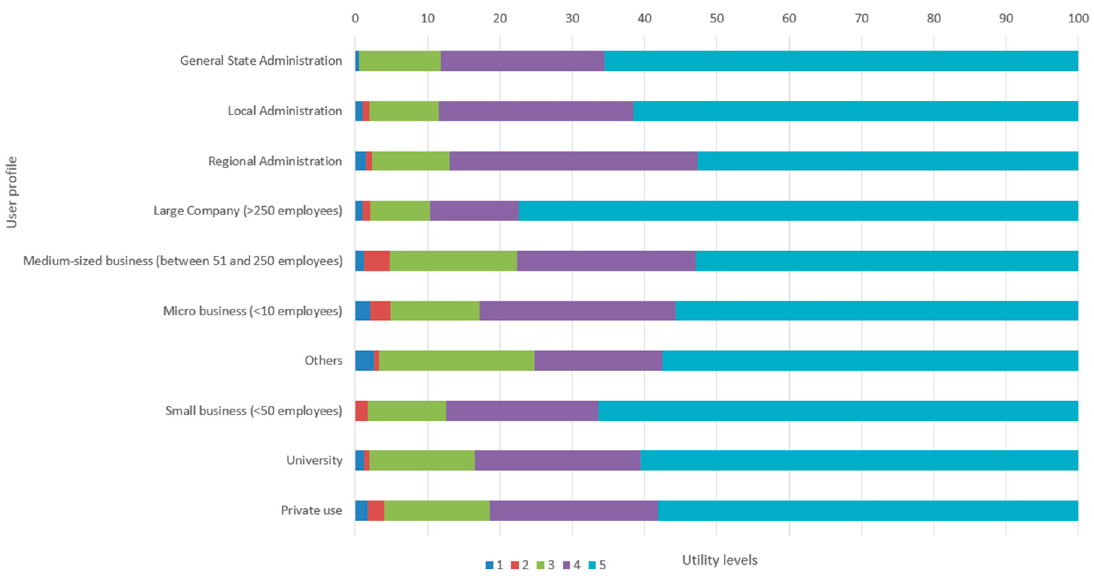
Figure 4. Percentage of the utility levels assigned per user profile.